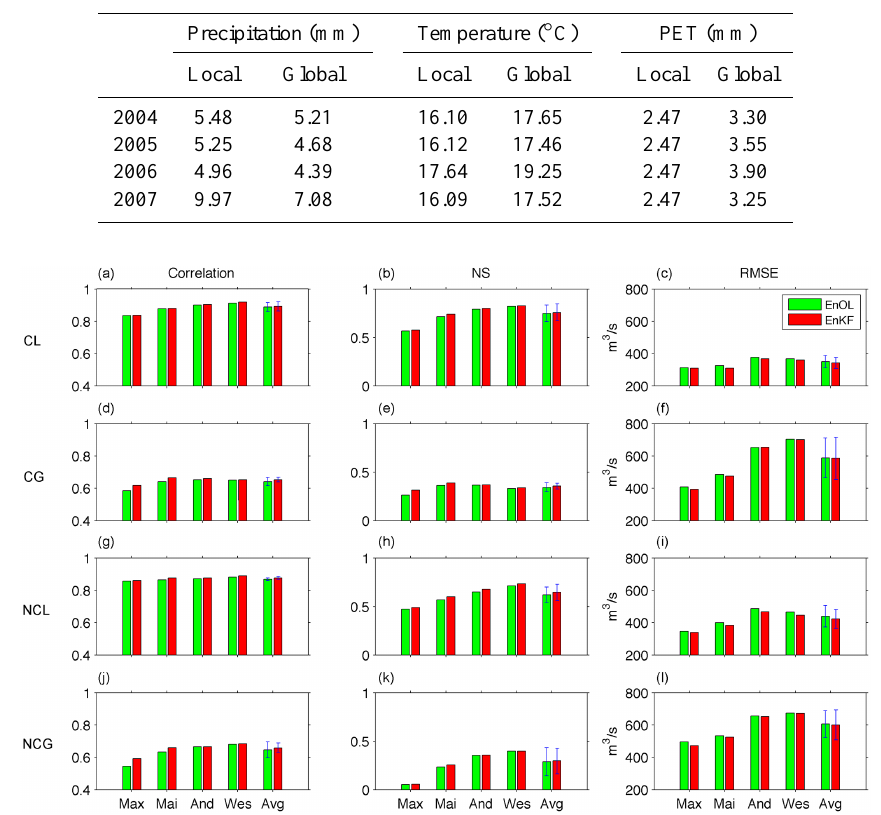
Table 2. Daily mean values of the forcing data at Sundern during summer (JJA) months.